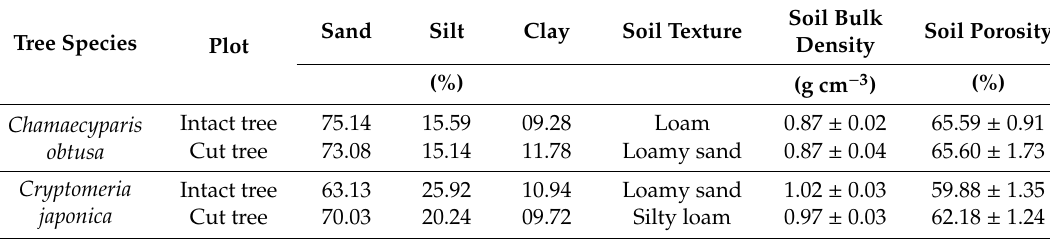
Figure 1. Sampling design around individual trees and stumps. Table 1. Basic soil characteristics.